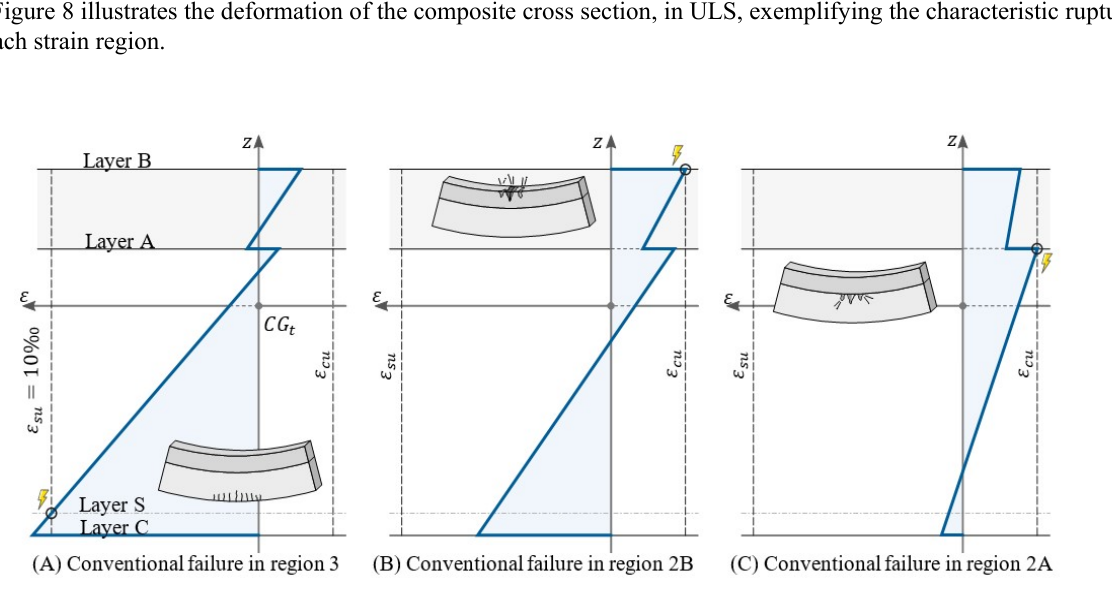
Figure 8. Deformation of the composite cross section in ULS in the total